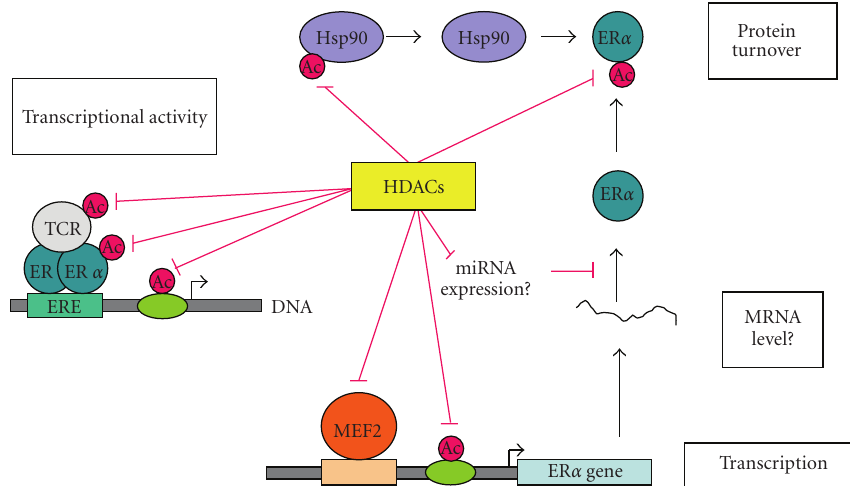
Figure 1: HDAC and estrogen signaling. HDACs are involved in estrogen-genomic mechanisms mediated in part through estrogen response element (ERE) targeting. ER α and numerous transcriptional coregulators (TCR) are acetylated proteins (acetyl mark is represented by a red circle) which are substrates for HDAC. By removing acetyl marks, HDAC regulate the transcriptional activity of ER α . HDACs also regulate the expression of ER α at the transcriptional level, in part through the control of MEF2 activity. They also modulate the level of ER α mRNA by a mechanism which might involve miRNA expression. Finally, HDACs also regulate ER α stability, and one mechanism appears to involve Hsp90